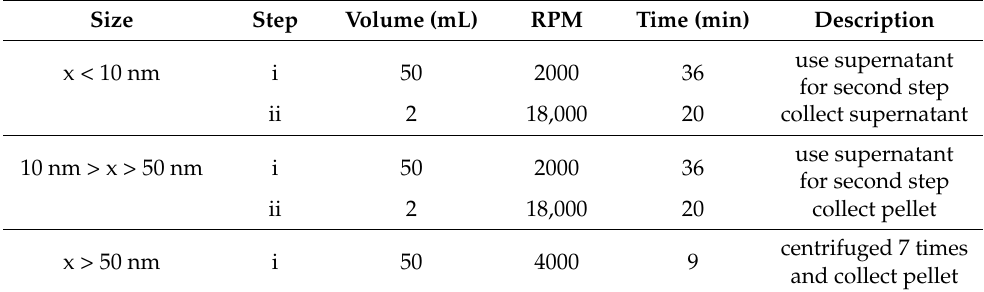
Table 1. Centrifugation protocol for particle size x < 10 nm, 10 nm > x > 50 nm, and x > 50